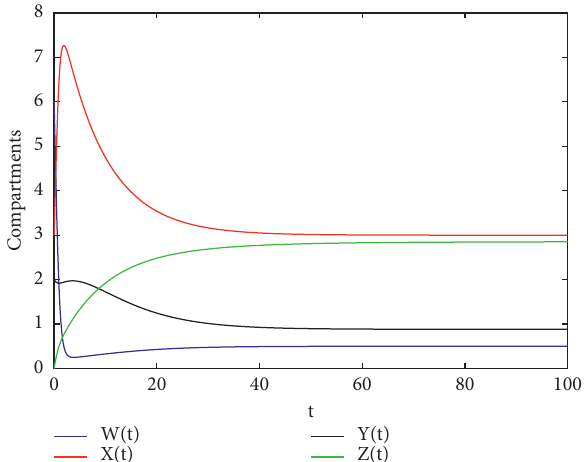
Figure 4: Graphical representation of the series solution for all the quantities of the considered model (2) with ζ �